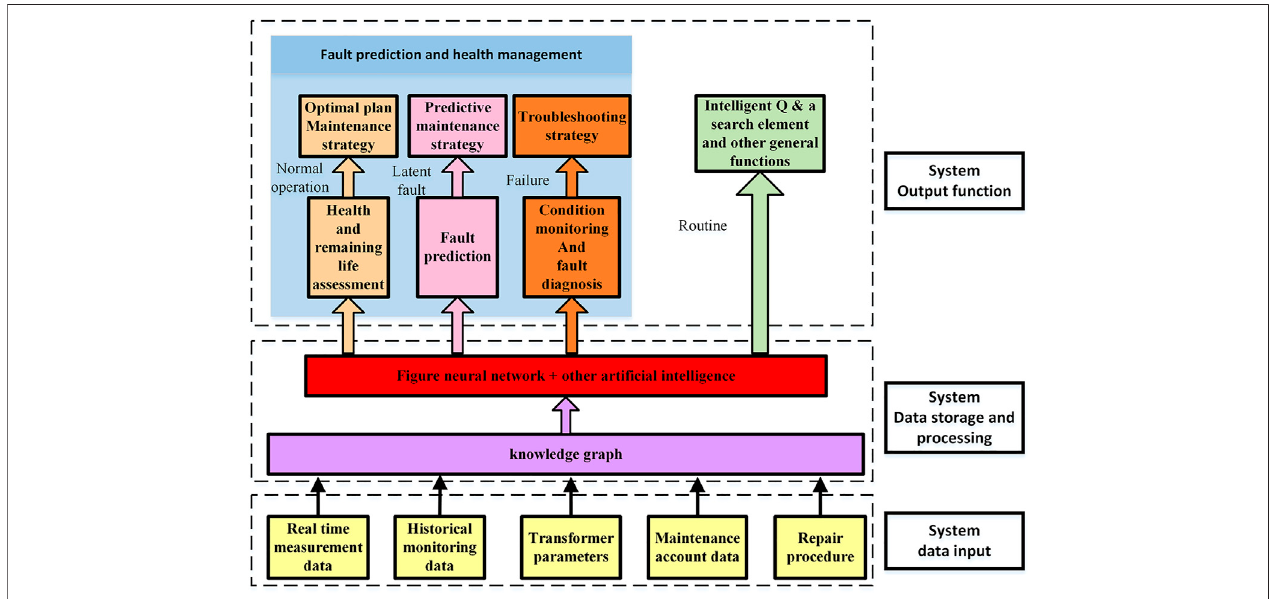
FIGURE 1 | Overall functional architecture of the